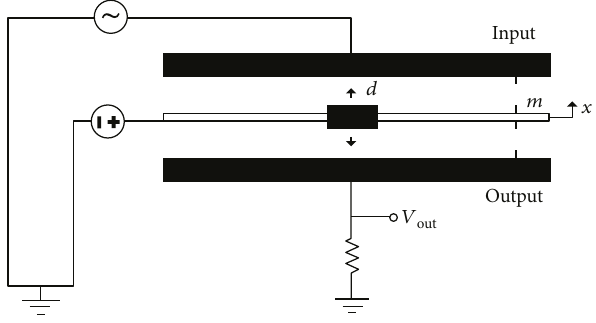
Figure 1: Oscillator microelectromechanical